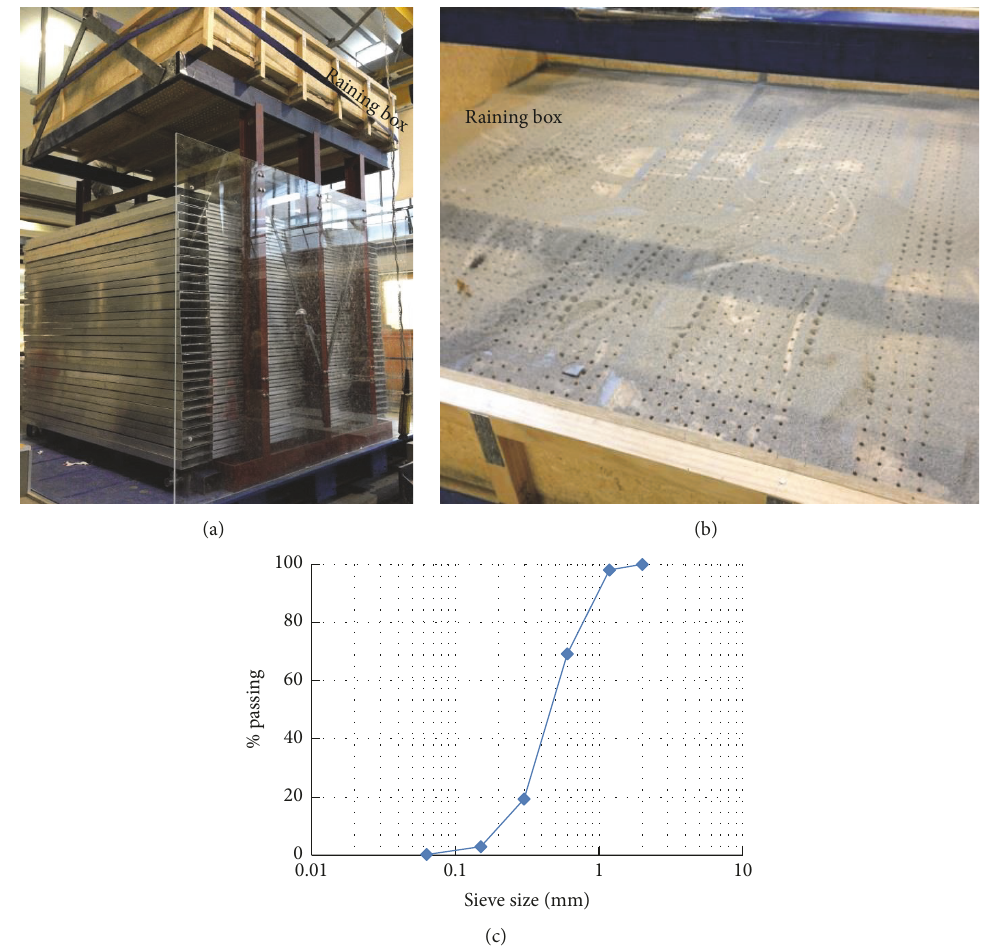
Figure 5: Test setup: (a) laminar box with (b) the raining box and (c) particle size distribution.